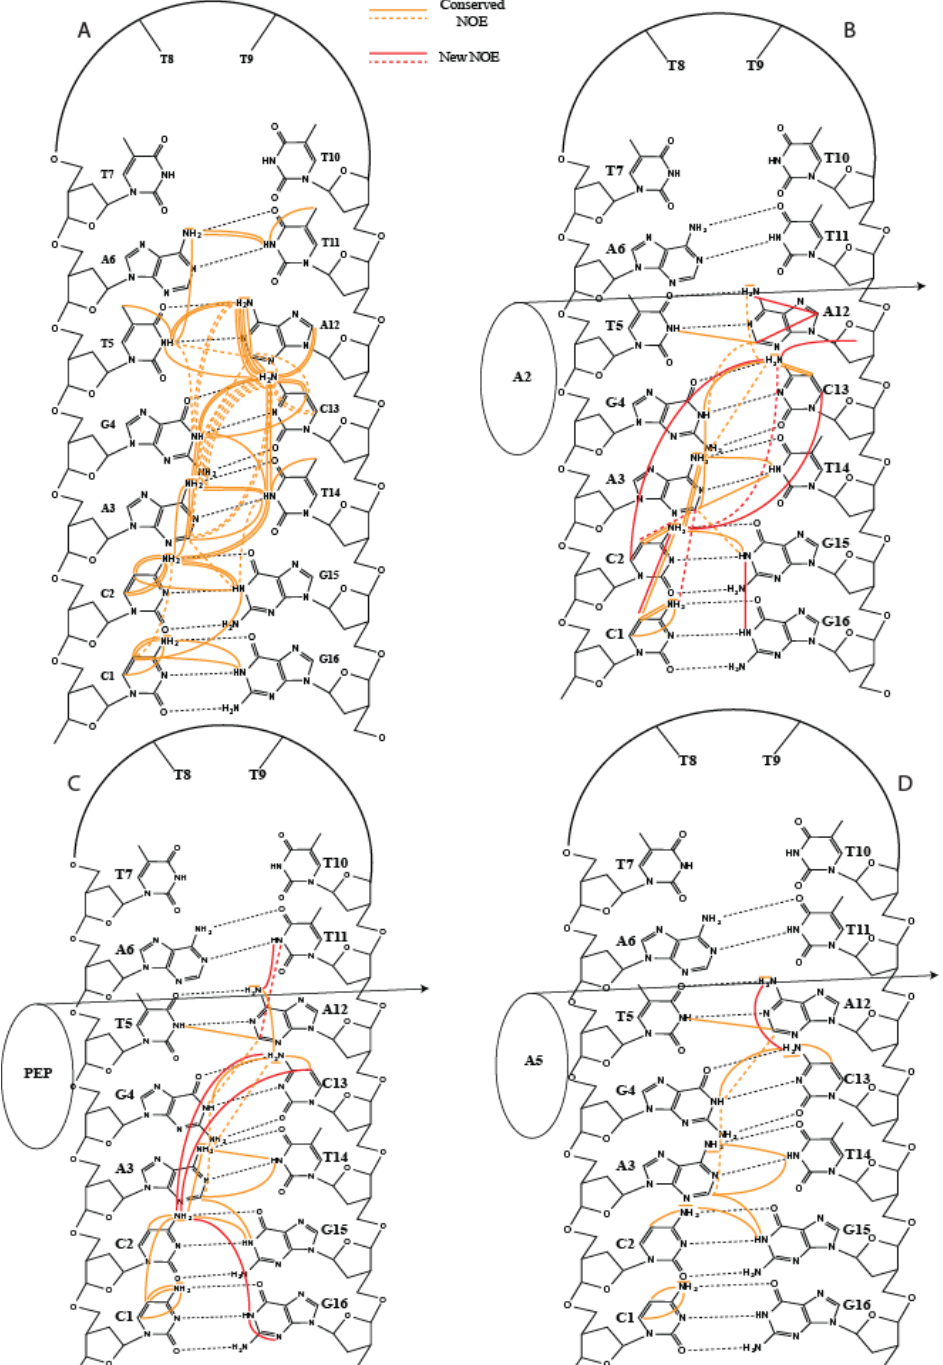
Figure 6. Schematic representation of the NOE connections between the exchangeable protons for: ( A ) free OL 2 . ( B – D ) OL 2 bound to Zn(II)BLM in H 2 O at 5 ◦ C. Dashed and continuous lines both represent NOEs, and are used together to avoid confusion in busy regions of the scheme. The conserved (orange) and new (red) NOE connectivities shown correspond to spectra in Figures 4 and 5 and are also listed in Table S1. The NOE connectivities shown for free OL 2 correspond to spectra in Figure 3 and are also listed in Table S1.